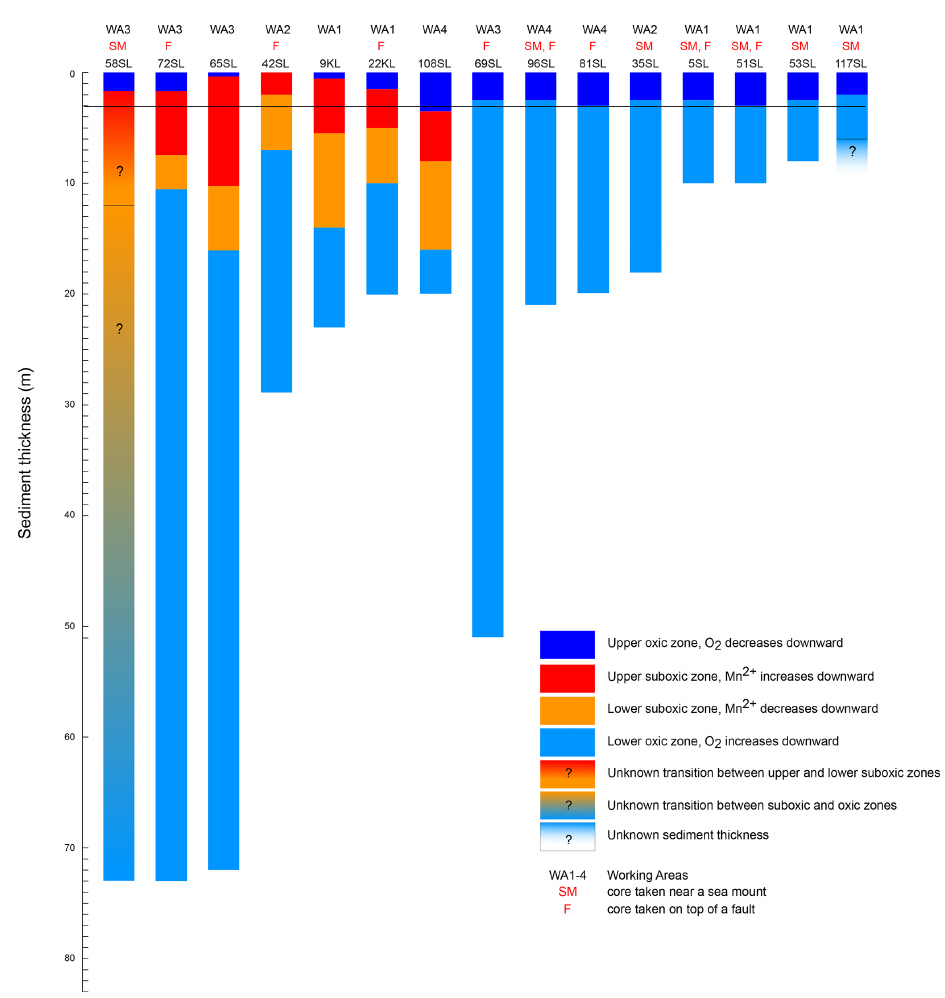
Figure 5. Compilation of oxygenation states of cores for the entire sediment column (sediment surface to basement) taken during RV Sonne cruise SO240. Sediment thickness is based on seismic and parasound data (Kuhn et al., 2015); oxidation state based on core porewater oxygen and manganese concentrations. Note that for the totally oxic cores (blue only) the oxygen minimum (where the downward dark blue and upward light blue oxygen profiles meet) is always in the upper few metres. The upper oxic–suboxic transition also occurs in the upper few metres. The black line at 3m depth marks the lower limit of the upper oxic zone for all cores except for